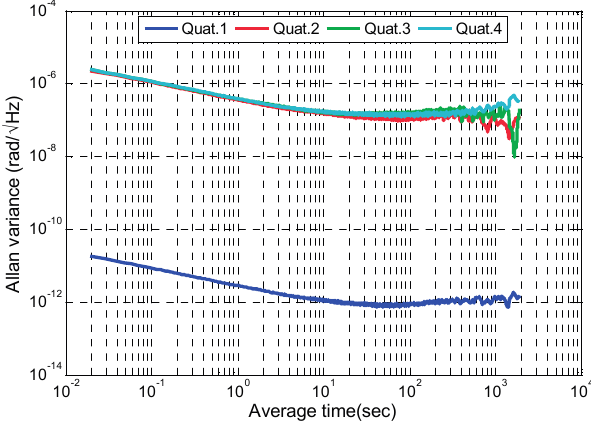
Figure 5. Allan variance of the fourth dimension quaternion